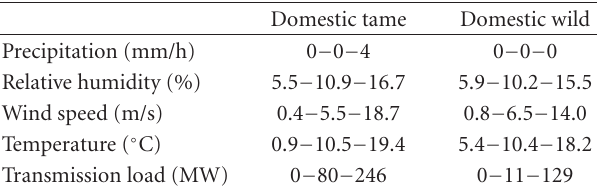
Table 1: Minimum, median, and maximum of the covariate variables included in model